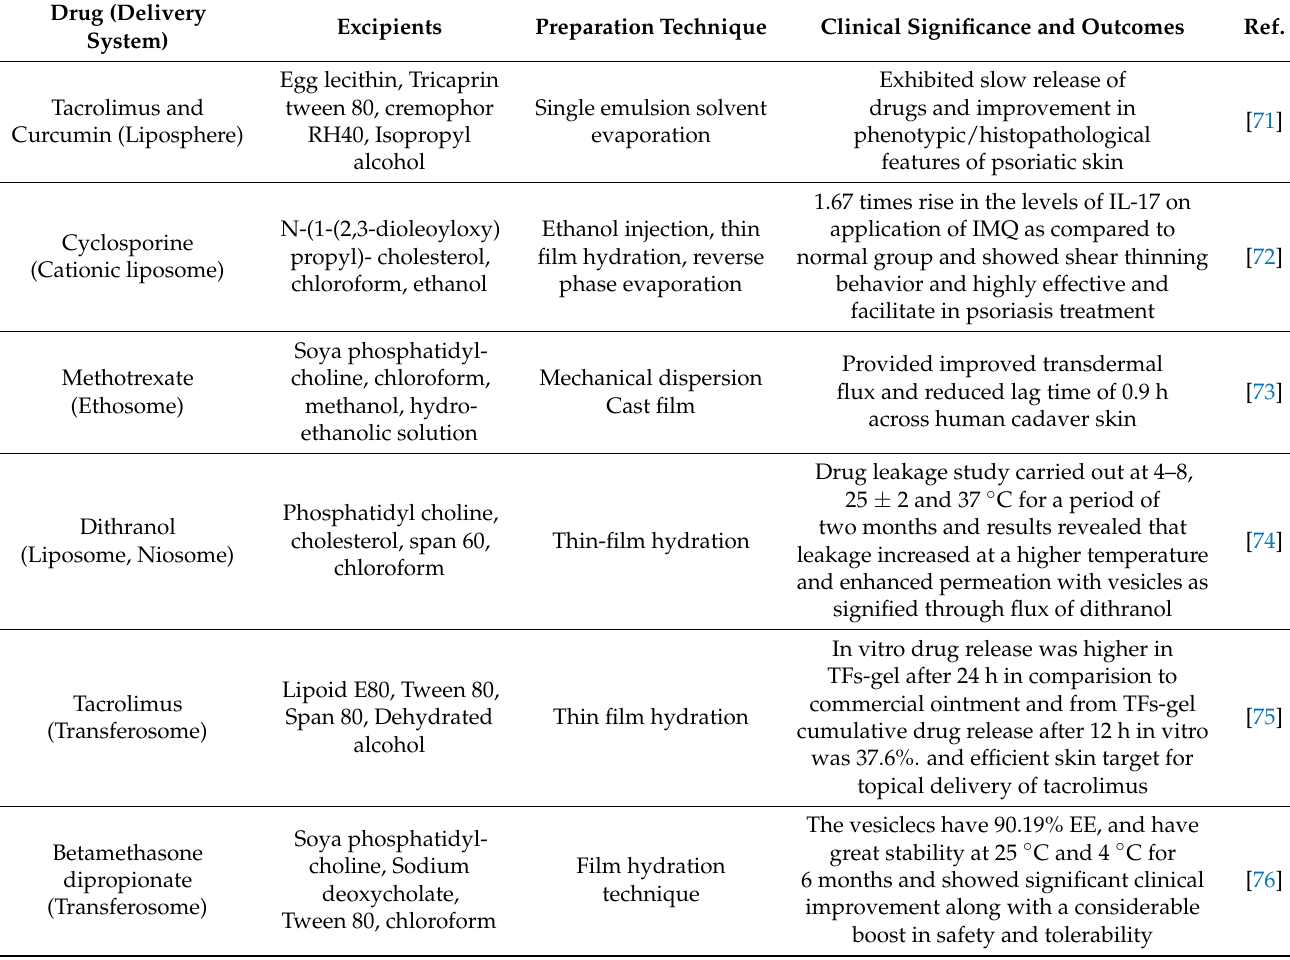
Table 6. Recent studies in vesicular drug delivery system for psoriasis